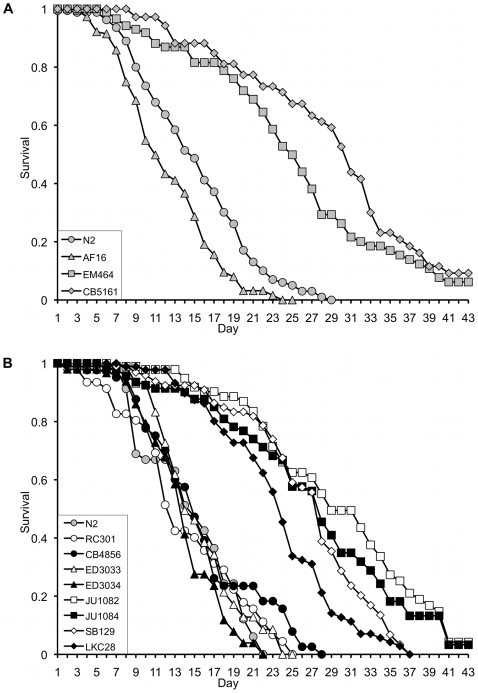
Lifespan analysis.(a) Hermaphrodite (N2, AF16) or female (EM464, CB5161) animals at the fourth larval stage (L4) were transferred onto plates pre-seeded with OP50 and monitored for survival over fifty days. Whilst hermaphrodite animals show 100% lethality over this period, survival is significantly higher for both gonochoristic species (p<0.0001, Table S1), with more than 50% of animals surviving longer than twenty days. (b) This effect is conserved across multiple wildtype isolates of each species.